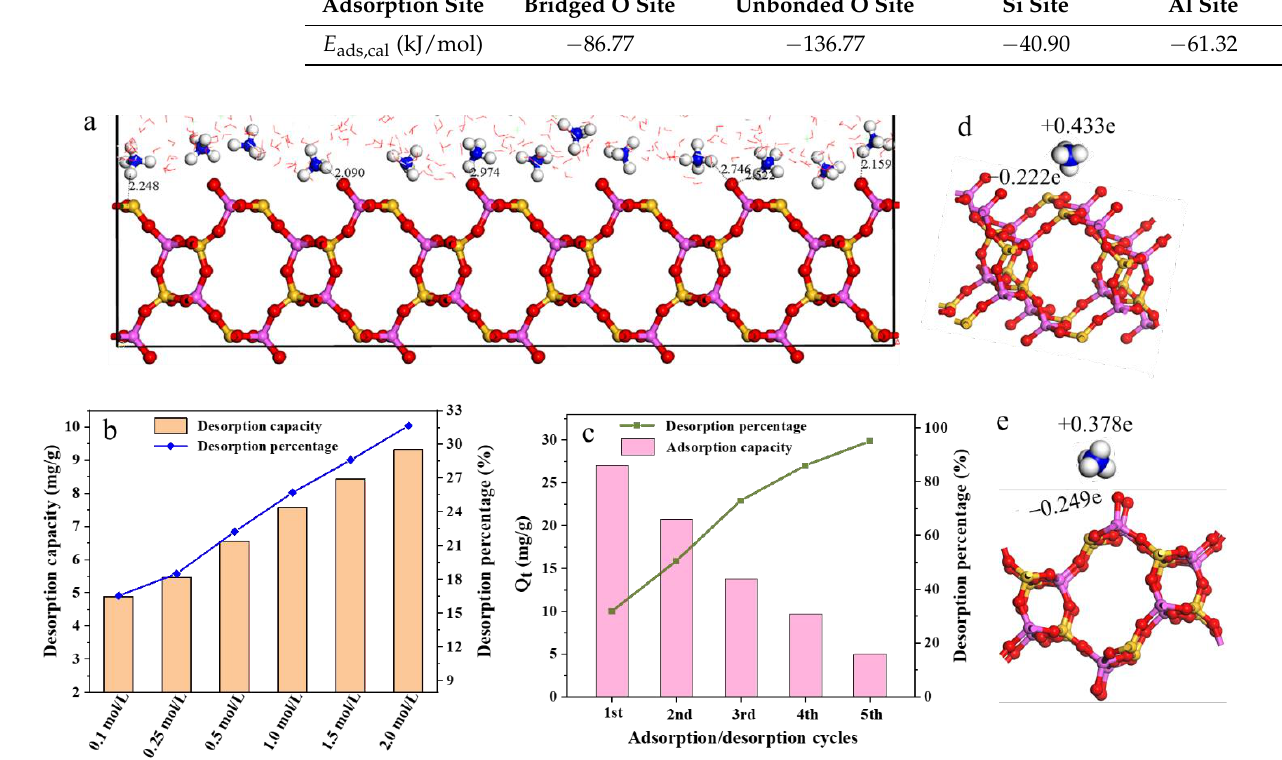
Figure 5. Visualization of ammonium adsorbed on the framework of natural zeolite. ( a ) Hydrogen bonding of ammonium ion with O atom in the zeolite framework; ( b ) Zeolite regeneration in NaCl solution with different concentrations; ( c ) Adsorption/desorption cycles using 2 mol/L of NaCl solution; ( d ) Hirshfeld charges between ammonium and the bridged O atom in the zeolite framework; ( e ) Hirshfeld charges between ammonium and the unbonded O atom in the zeolite framework. Yellow represents Si atoms, pink = Al, red = O, white = H, blue = N.